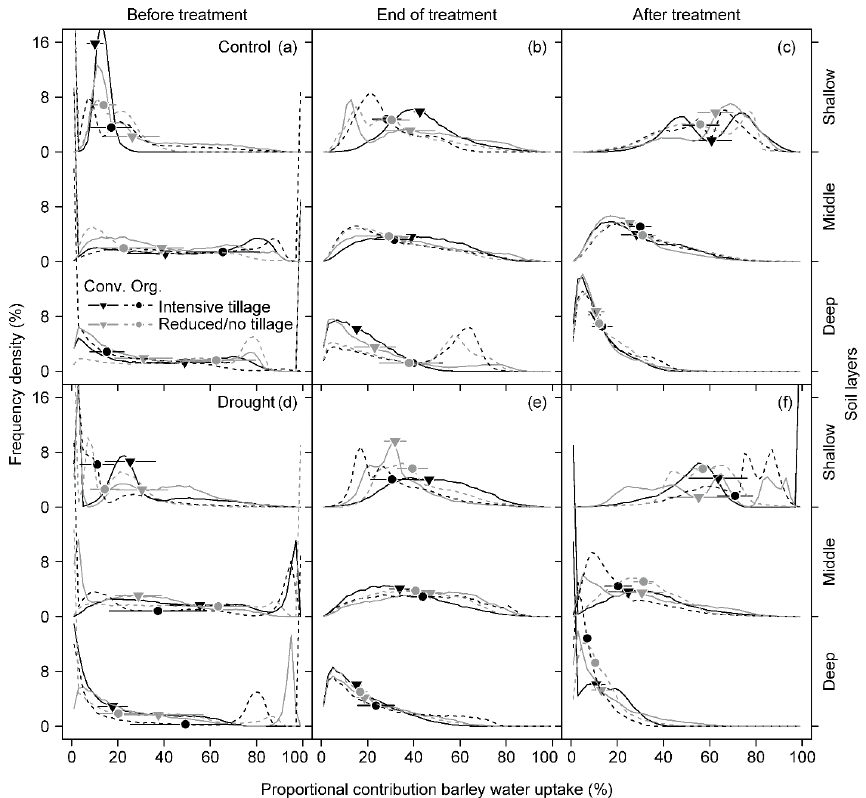
Figure 5. Frequency density distribution of model outputs on the proportional contribution of soil water to barley water uptake from the shallow (0–20cm; sum of 0–5, 5–10, and 10–20cm), middle (20–40cm; sum of 20–30 and 30–40cm), and deep (40–60cm) soil layers under different cropping systems (a, b) before the drought treatment on 7 May, (c, d) at the end of the treatment on 25 June, and (e, f) after the treatment on 11 July 2018. Frequency density was derived from 10000 simulations at a 2% increment of mixing models using δ 18 O for each subplot (Conv. for conventional and Org. for organic). Data were pooled for all subplots in each cropping system. Symbols on the curves indicate the median of the model outputs for each soil layer. Means and 1SE (horizontal bars) of each cropping system are given ( n =